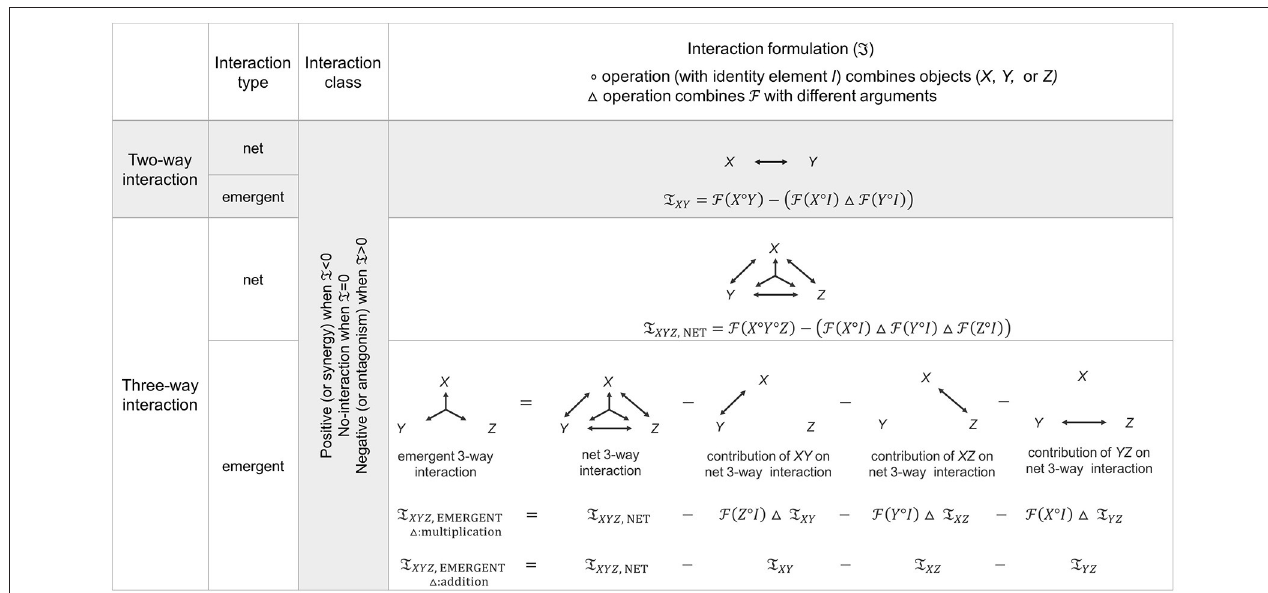
FIGURE 2 | Generalized form of interaction diagrams and measures. Two-way and three-way interaction diagrams and measures ( T ) over distinct interaction types, general functionals ( F ), and operations (, △ ) are given. Empirically, classification of pairwise interaction requires measurements from each single component alone as well as measurements from each pairwise combination of components. On the other hand, classification of three-way interactions requires measurements from all possible subsets: measurement under each single-component alone, measurement from all pairwise subsets, and measurement from triple-component combination. Theoretically, for two-way interactions, the definitions of net and emergent interactions are identical. On the other hand, net and emergent interactions are not the same at the three-way level because the net three-way combination subsumes the pairwise combination effects of each pair ( XY , XZ , YZ ). Therefore, the emergent 3-way interaction (the diagram on the bottom far left) is expressed by subtracting all lower-order contributions from the net 3-way interaction. The interaction classification is obtained from the sign of the interaction measure, T , where T = 0 represents no-interaction, T < 0 represents synergy (positive interaction), and T > 0 represents antagonism (negative interaction). See Figure 1 for a toy example of consumer-resource systems that depicts different interaction classes: synergy, no-interaction, and